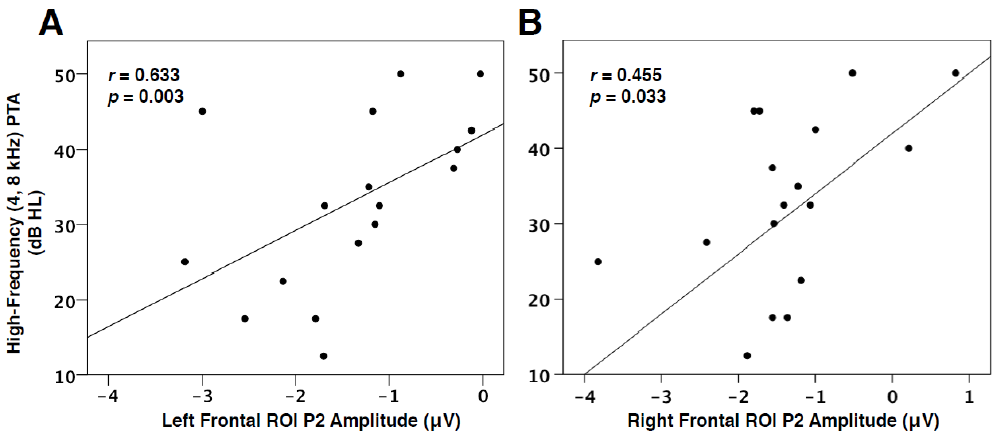
Figure 6. PTA and VEP Frontal ROI Correlations . (A) The correlation of VEP P2 amplitude in the left frontal ROI as a function of pure-tone threshold averages (PTA) at 4000 and 8000 Hz (best ear). P2 amplitude is shown on the horizontal axis in microvolts and threshold values on the vertical axis as decibels hearing level (dB HL). The Spearman’s rank order correlation value and significance level